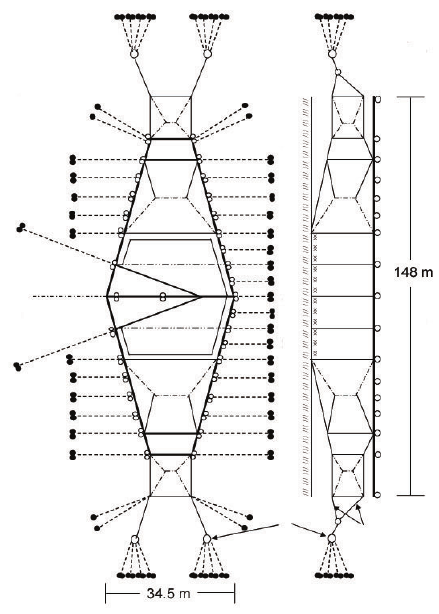
Figure 2. Schematic diagram of the set net fishery structure.